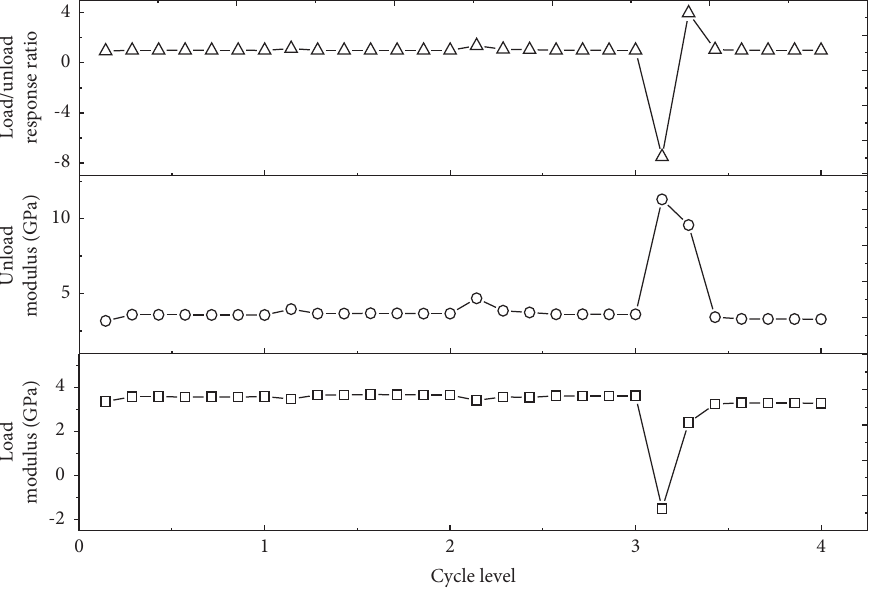
Figure 15: Load/unload response